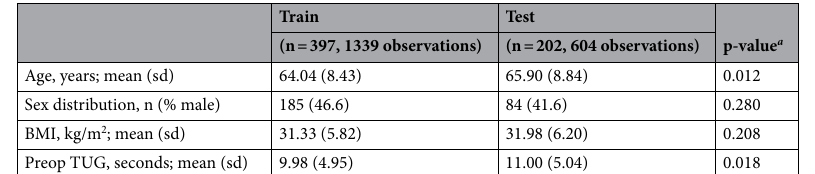
Table 1. Baseline characteristics of training and test datasets. a Continuous variables tested with one-way analysis of variance; Categorical variables tested with χ 2 test. Preop TUG, preoperative timed up and go time; sd, standard deviation; BMI, body mass